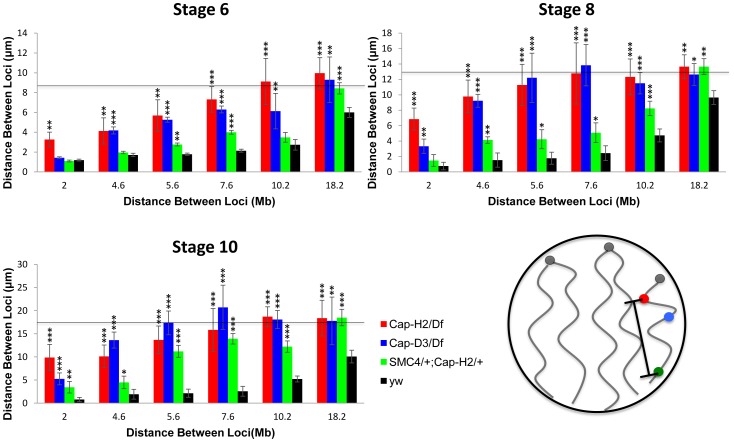
Condensin II promotes chromosome axial compaction.For developmental stage 6, 8, and 10, distances were measured between pairs of loci on the X chromosome. The X-axis indicates the distance between the loci in megabases and the Y-axis indicates their mean spatial separation in microns. The horizontal line indicates the average nuclear radius which is also a good approximation for the mean distance between two random points within a sphere. The following genotypes were assayed: Cap-H2Z3-0019/Df(3R)Exel6159, Cap-D3EY00456/Df(2R)Exel7023, y[1] w[67c23]; P(w[+mC] = lacW)glu[k08819]/+; Cap-H2Z3-0019/+, wild type (y[1] w[67c23]). Bars represent standard errors. One asterisk signifies p<.05, two asterisks signifies p<.01, and three asterisks signifies p<.001. The cartoon in the lower right panel illustrates the axial length measurements being made between different loci.